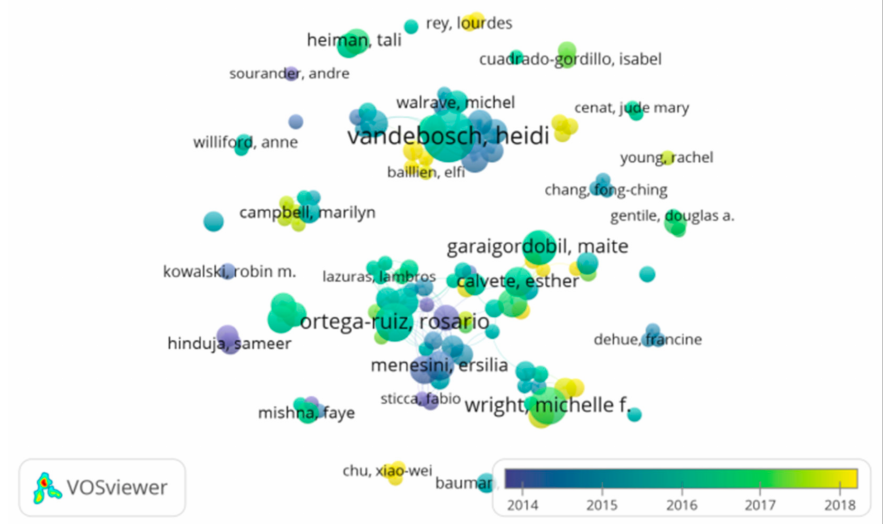
Figure 7. Visualization of authors by year.